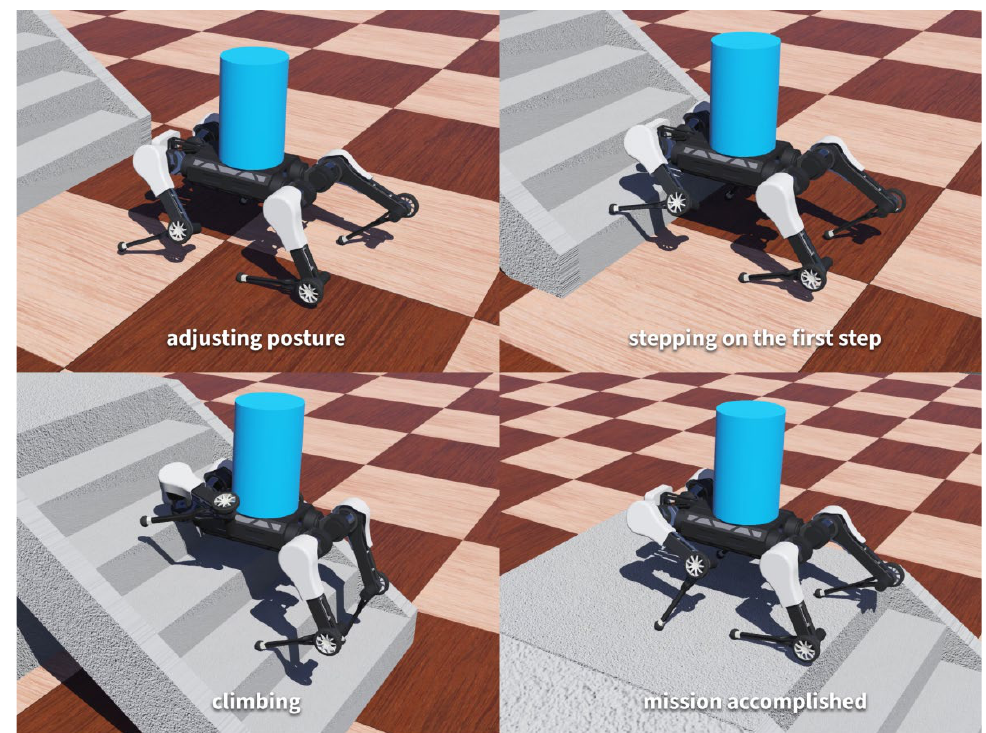
Figure 24. Simulation task. At 16.940 s, the robot stepped on the first step; at 46.085 s, the robot fully landed on the platform.